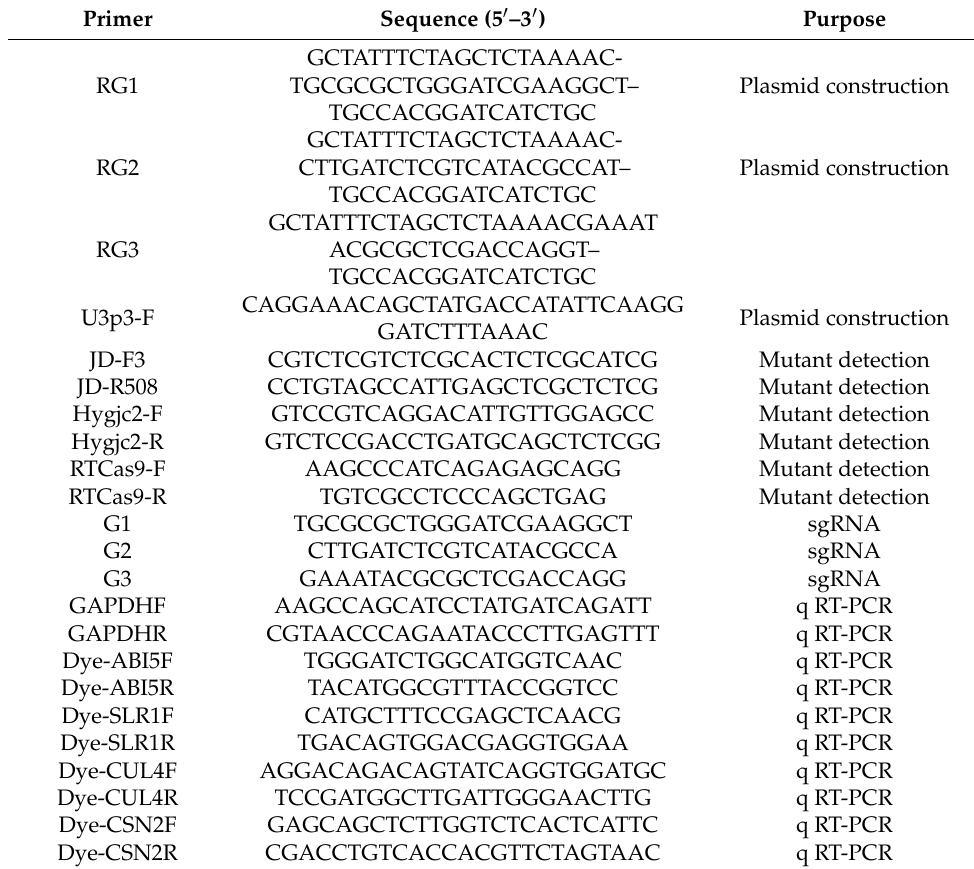
Table 1. All the primers that were used in this study.